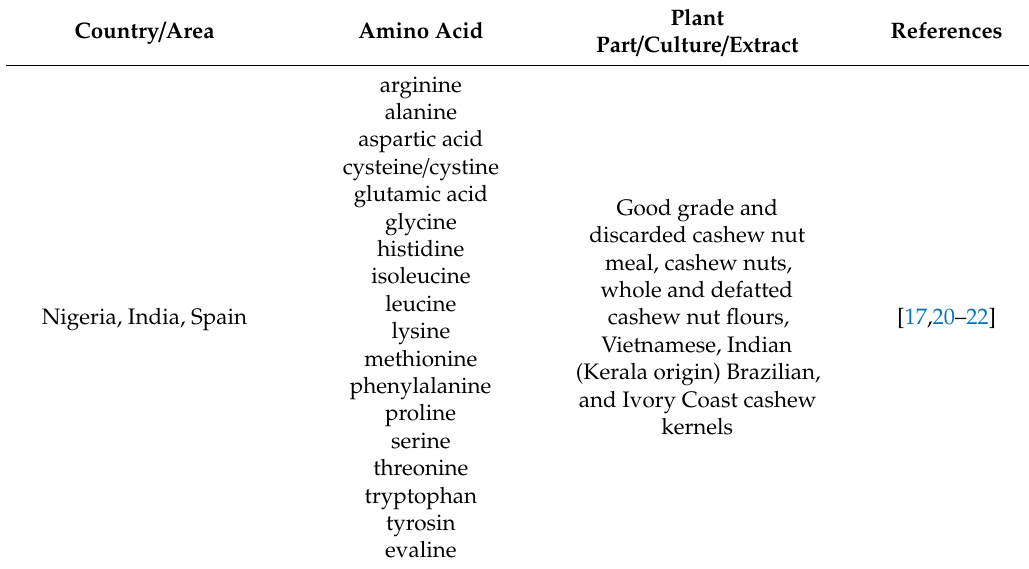
Table 1. Amino acids present in Anacardium occidentale